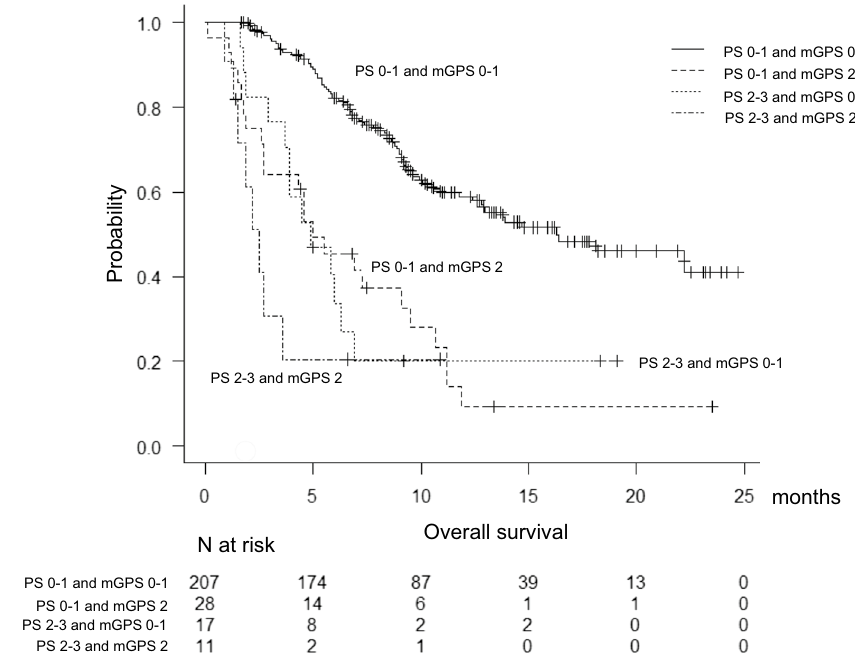
Fig. 2 Kaplan–Meier curves for overall survival (OS) according to four categories. Patients with PS 0–1 and mGPS 2 had short survival, similar to patients with PS2–3 and mGPS